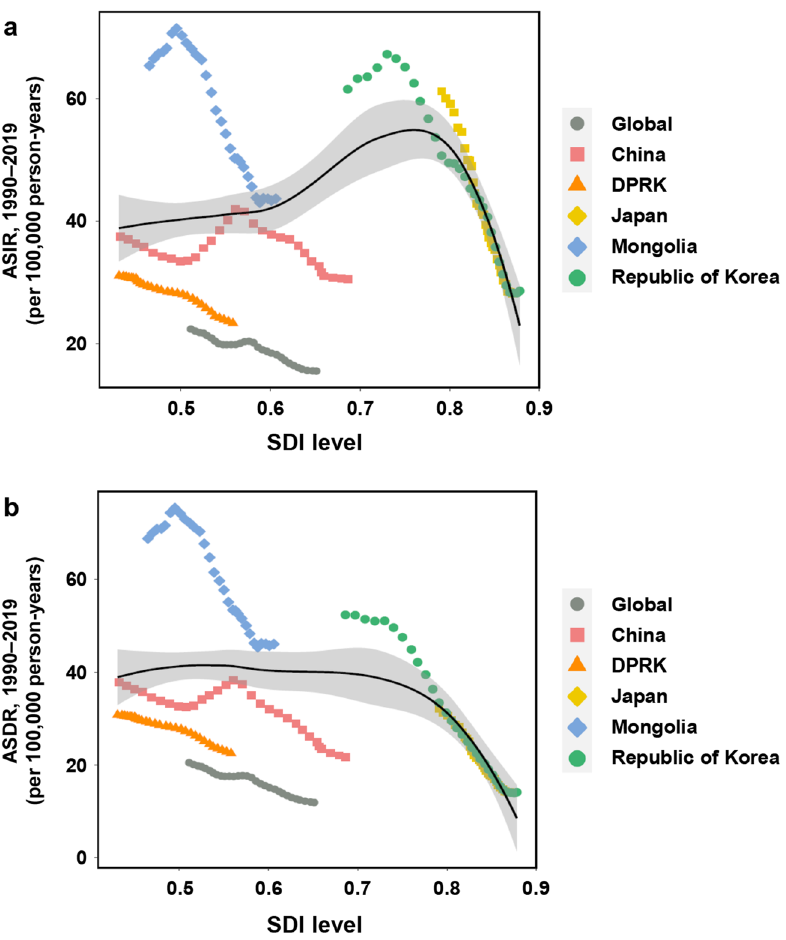
Figure 5. ASIRs ( a ) and ASDRs ( b ) of gastric cancer worldwide and in five Asian countries from 1990 to 2019 according to SDI. ASDR, age-standardized death rate. ASIR, age-standardized incidence rate. DPRK, the Democratic People’s Republic of Korea. SDI, sociodemographic